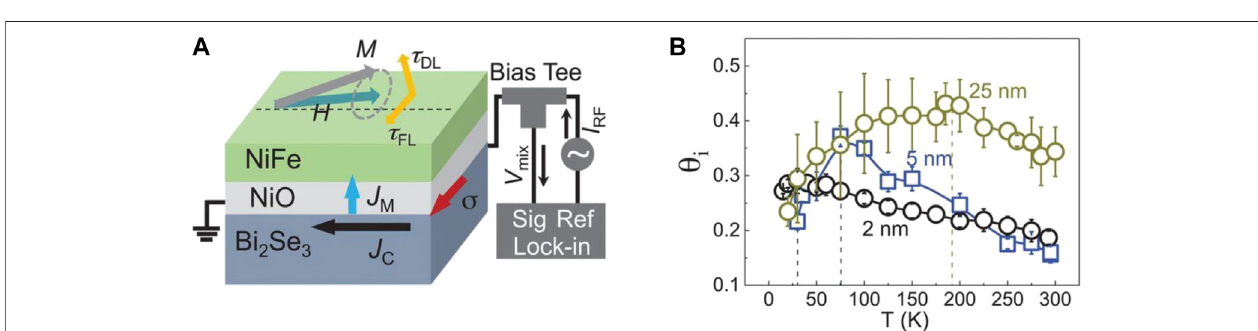
FIGURE 7 | (A) Schematic diagram of spin-torque ferromagnetic resonance (ST-FMR) measurement system (Wang et al., 2019). J C is the RF current, σ is spin polarization direction, and J M is magnon current. (B) Variation of spin-torque ratio θ i of three NiO layers with different thicknesses versus temperature T, where θ i (cid:3) J i /J C represents the generation ratio of input current to magnon current. (A – B) Reprinted with permission from Wang, Y., Zhu, D., Yang, Y., Lee, K., Mishra, R., Go, G., et al. (2019). Magnetization switching by magnon-mediated spin torque through an antiferromagnetic insulator. Science 366 (6469), 1125 – 1128. Copyright 2019 American Association for the Advancement of Science.